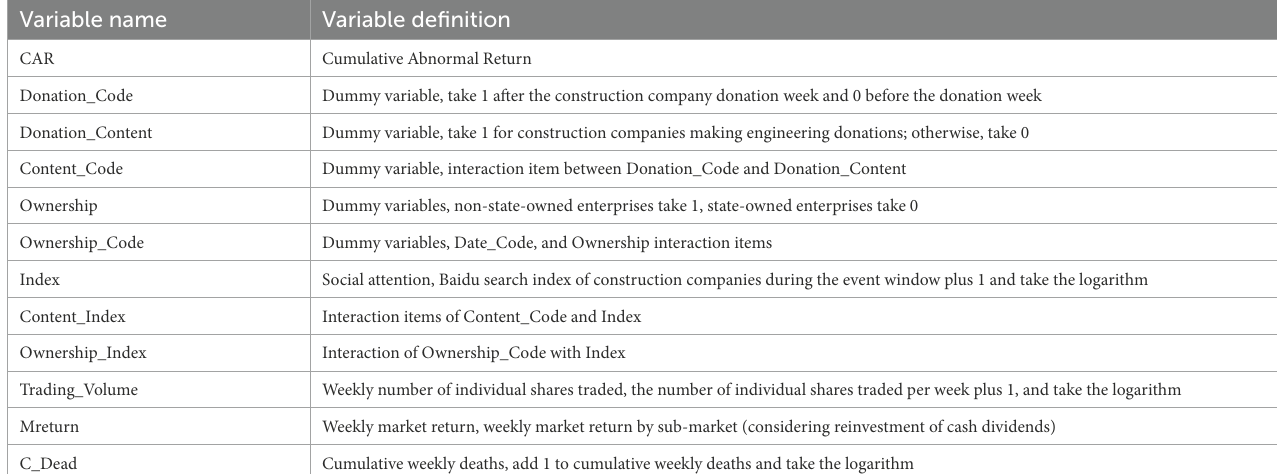
TABLE 1 Variable names and their